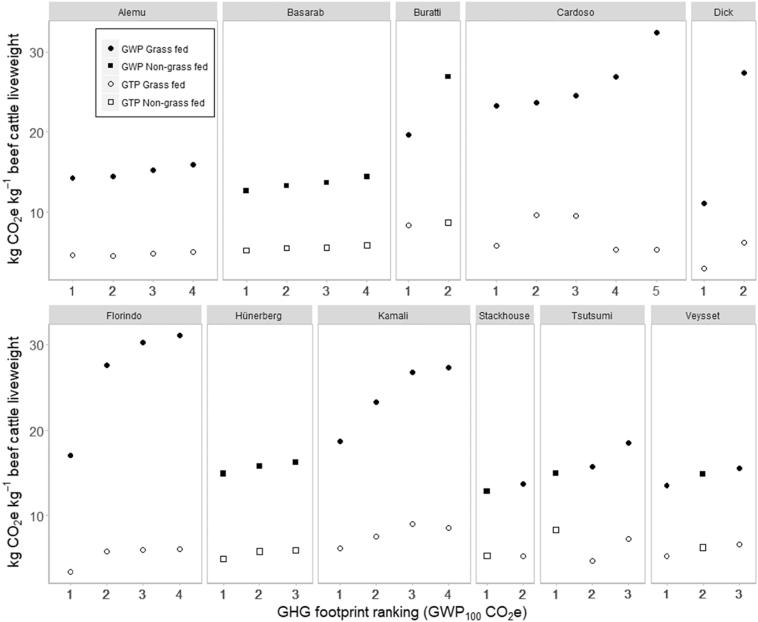
Differences in GWP100 and GTP100 CO2e for studies comparing multiple systems. Boxes represent the following individual studies, labelled by lead author: Alemu et al. (2017), Basarab et al. (2012), Buratti et al. (2017), Cardoso et al. (2016), Dick et al. (2015), Florindo et al. (2017), Hünerberg et al. (2014), Kamali et al. (2016), Stackhouse-Lawson et al. (2012), Tsutsumi et al. (2018), Veysset et al. (2010).